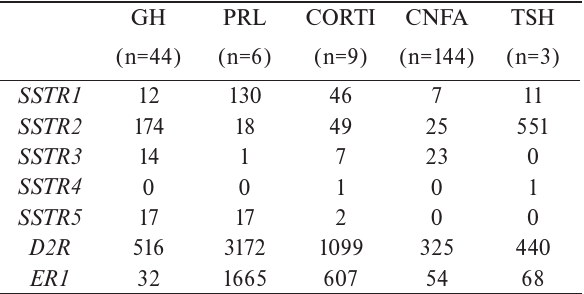
Table 3. Normalized expression of receptors (median values) in pituitary adenomas.